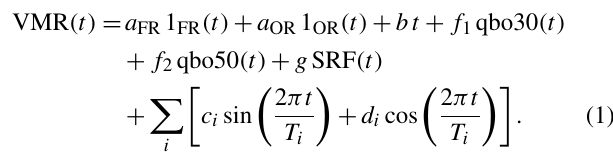
Figure 9. Mean CCl 4 profile difference between co-located MIPAS and ACE-FTS measurements (red) with standard deviation of the mean (red error bars). The standard deviation of the differences (orange), the estimated total random (green), and total systematic (blue) errors of the difference are also shown. The number of co- located pairs for each pressure level is reported on the right side of each graph. Each plot refers to a latitude interval as indicated in the